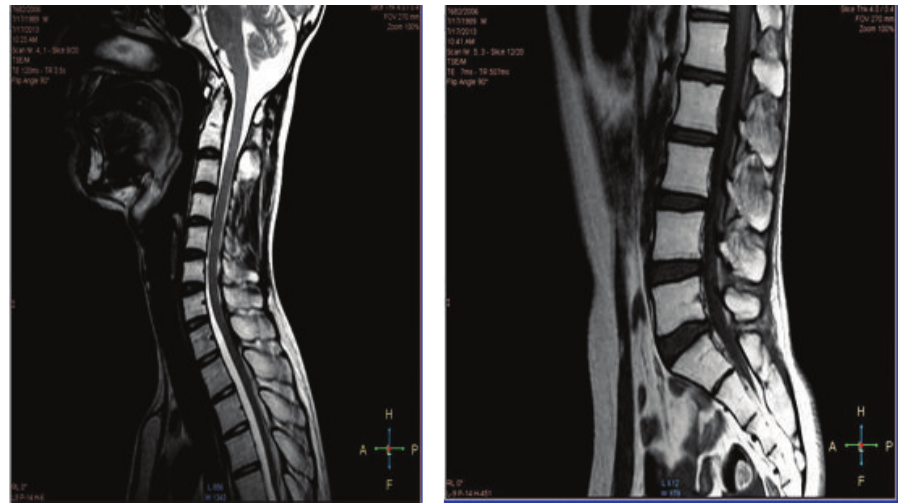
Figure 3: Posttreatment